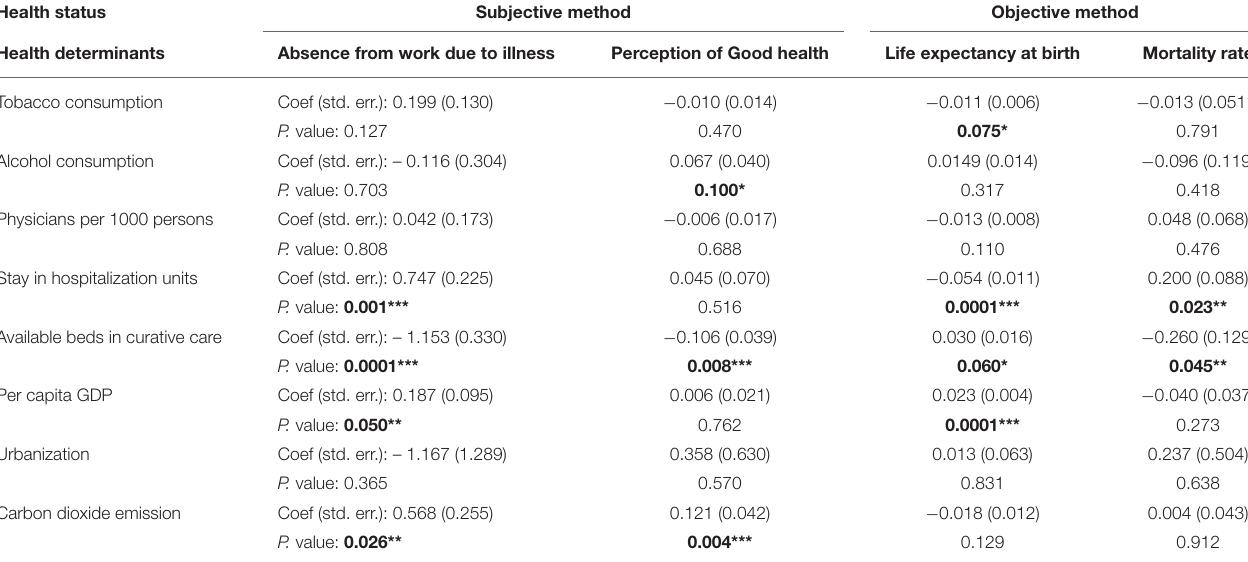
TABLE 2 | Generalized linear model results comparing subjective and objective measurement methods of health in the United States in